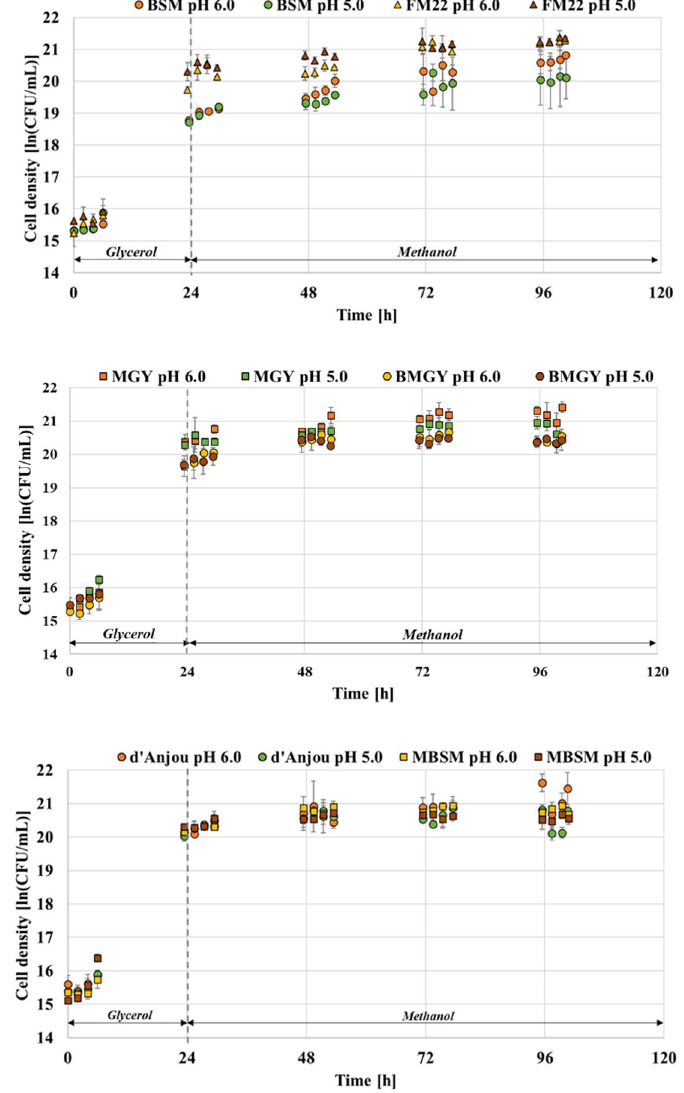
Figure 1. Growth comparison of P. pastoris at pH 5.0 and 6.0 when grown in commonly used fermentation media at 30 °C.